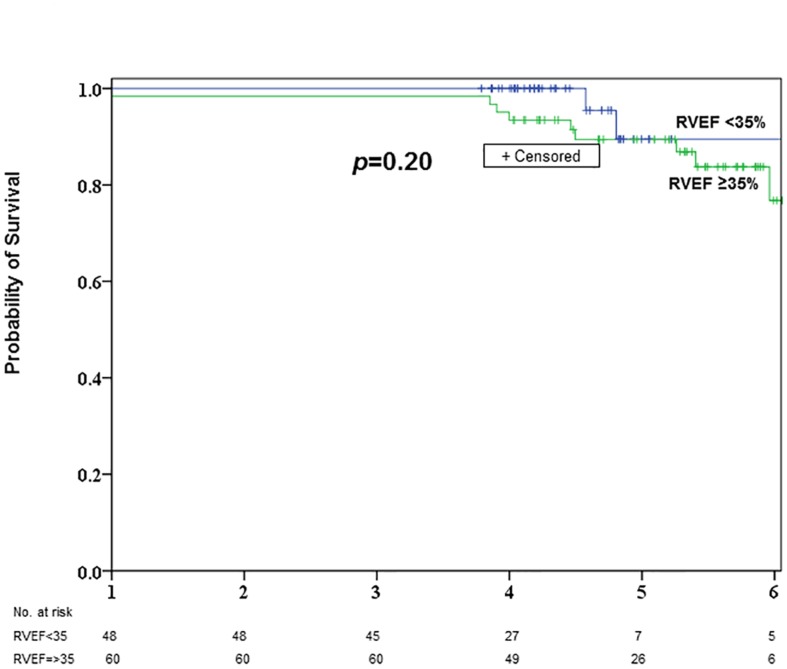
Kaplan-meier survival curve comparing patients with RVEF < 35% (n = 48) and RVEF≥ 35% (n = 61) undergoing CABG or valve procedures.The top curve corresponds to patients with RVEF <35% and the bottom curve to patients with RVEF≥ 35%. The number below each year indicates the number of patients at risk.